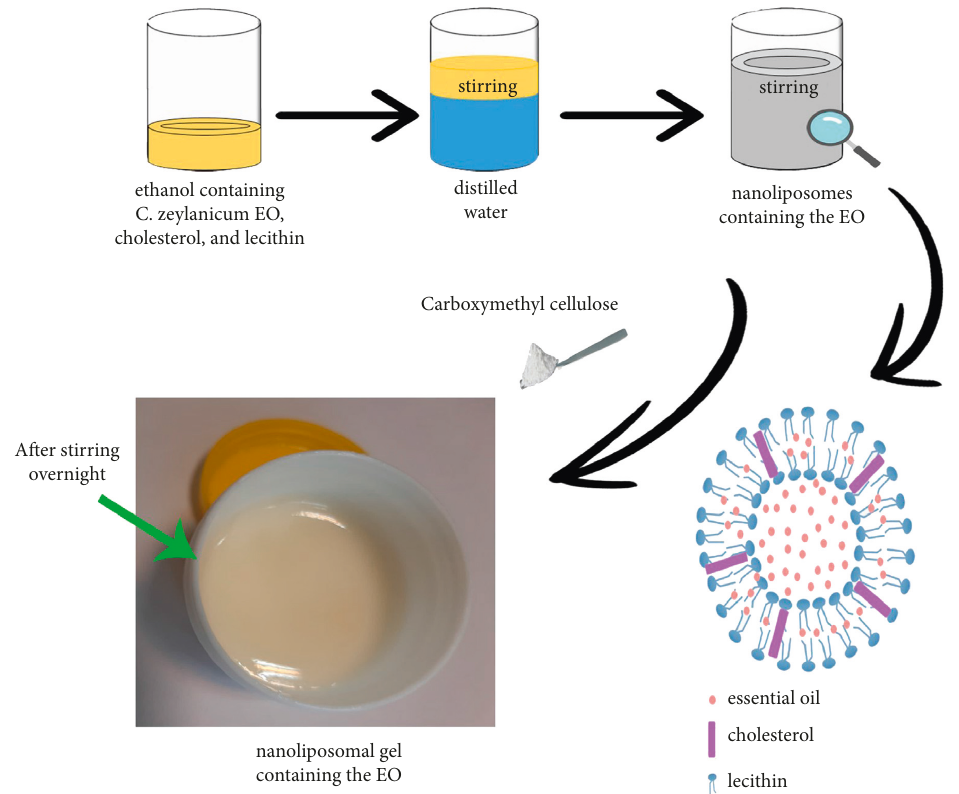
Figure 1: Preparation of the nanoliposomal gel containing C. zeylanicum